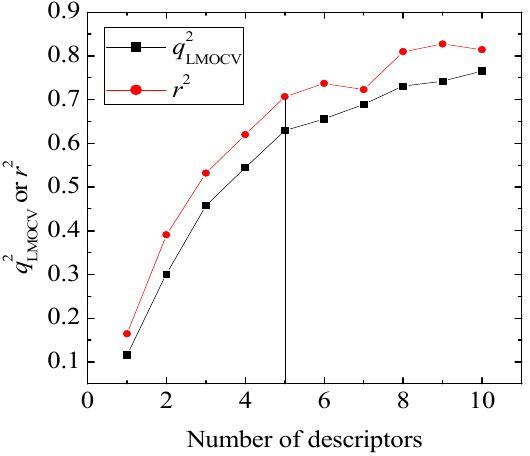
q ) vs. number of descriptors. LMOCV